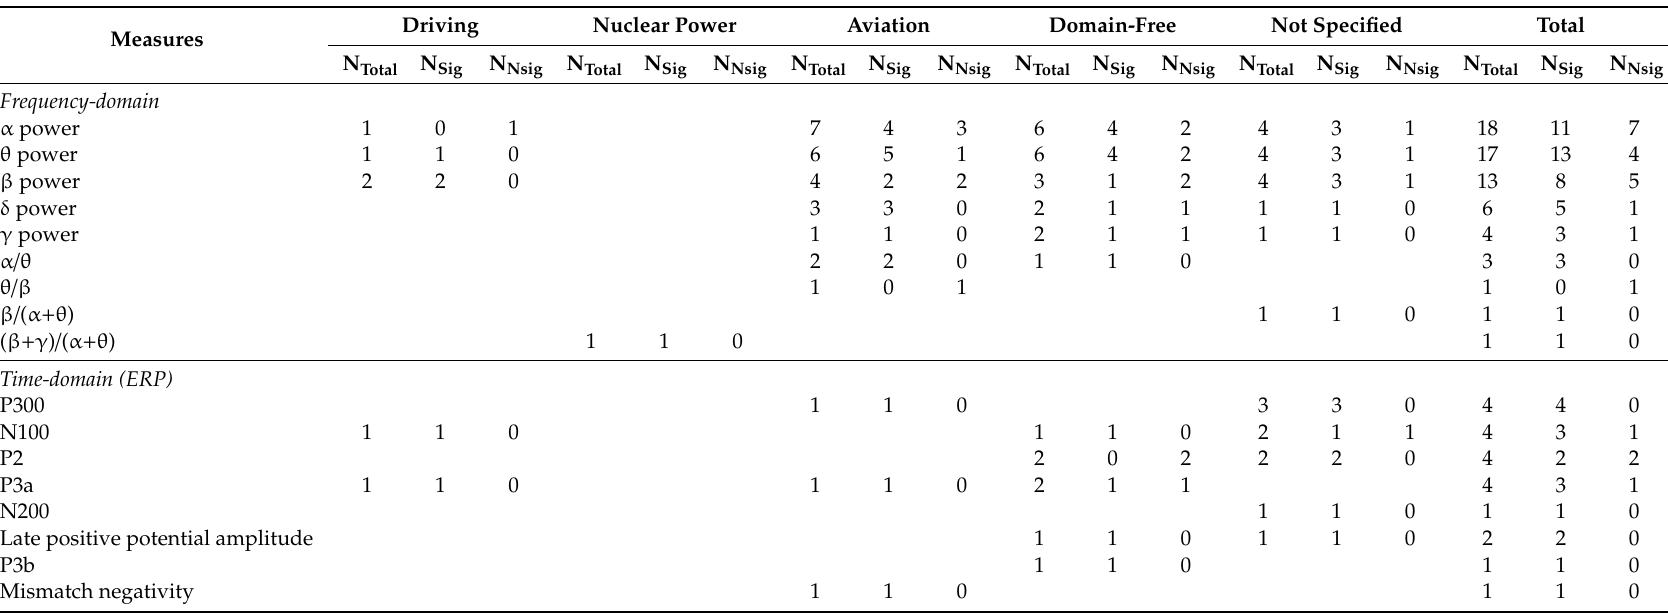
Table 6. Summary of EEG measures and their statistical significance reported in the reviewed studies.